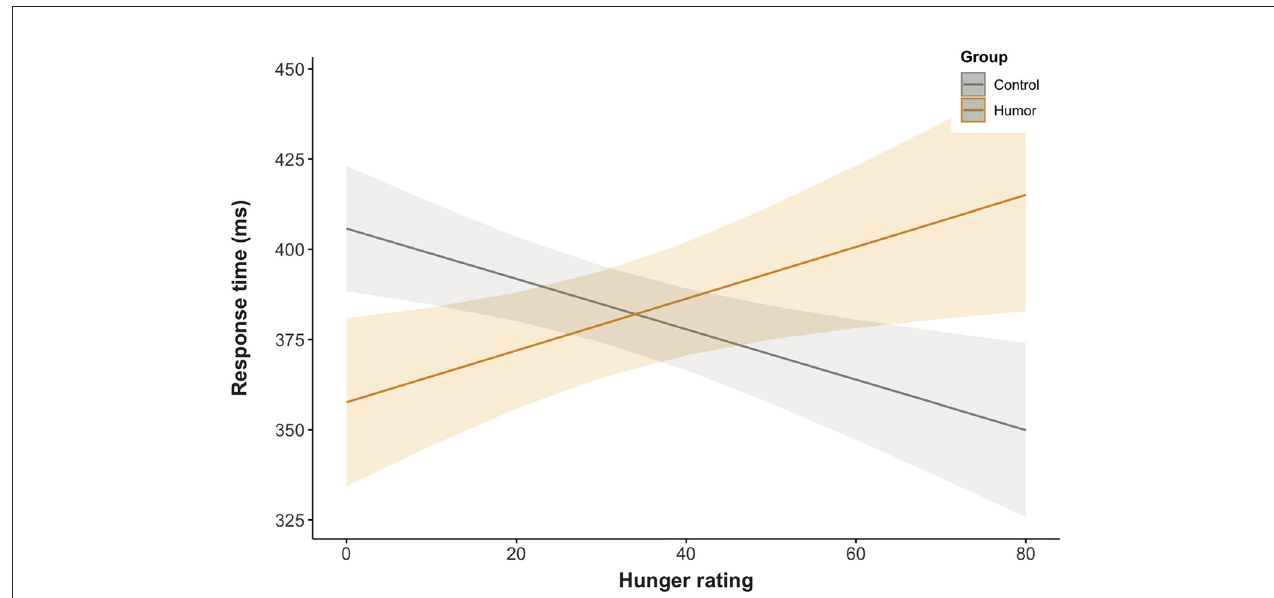
FIGURE 4 | Predicted marginal effects of group and hunger ratings on response times.